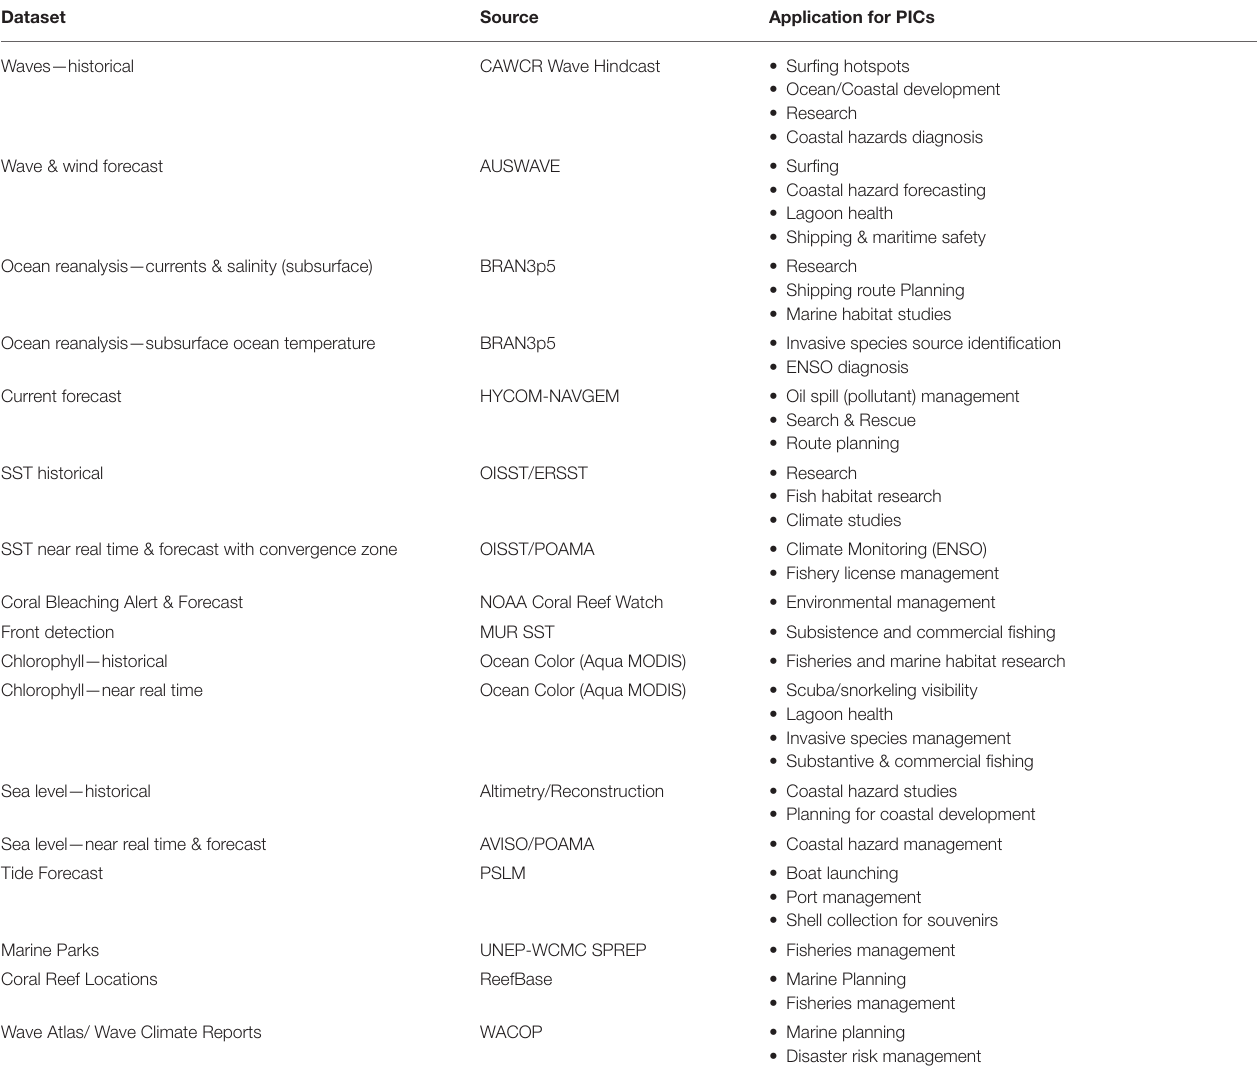
TABLE 1 | Datasets available within the Pacific Ocean Portal with data source and potential PIC applications.